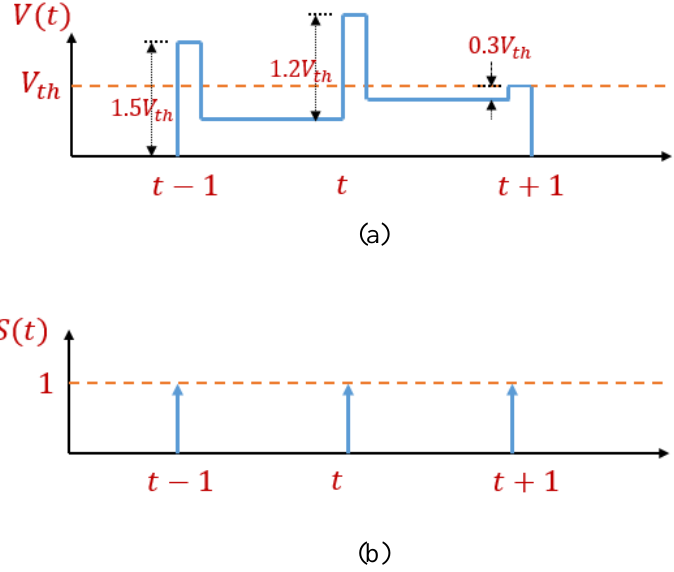
Figure A2. Soft-reset IF neuron model. ( a ) a IF neuron driven by a set of input neurons via weights; ( b ) spiking behavior of IF neuron